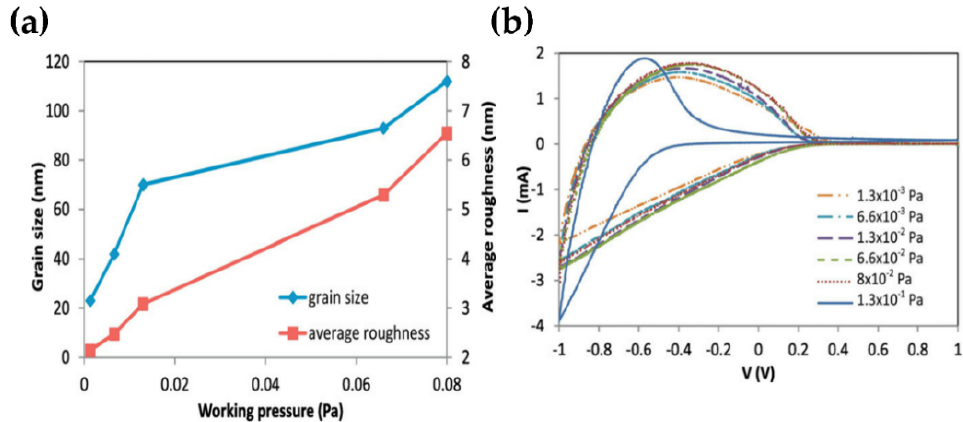
Figure 14. ( a ) Variation of grain size and average film roughness with the working pressure. ( b ) Cyclic voltammetry for WO 3 films deposited at different working pressures. Reproduced or adapted from [83].